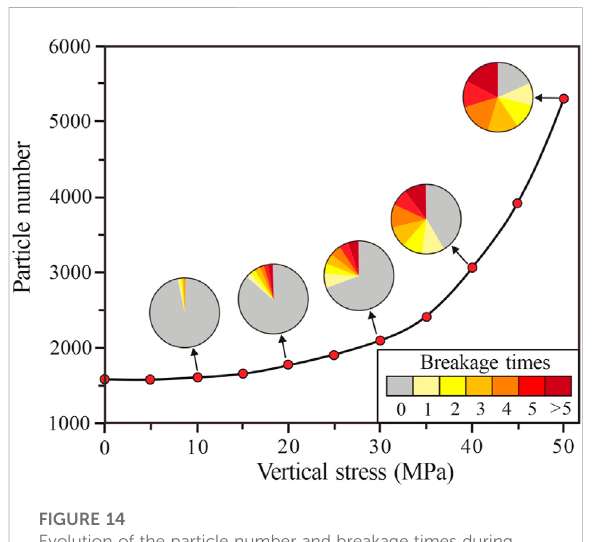
FIGURE 15 PSD evolution during the compaction of coarse